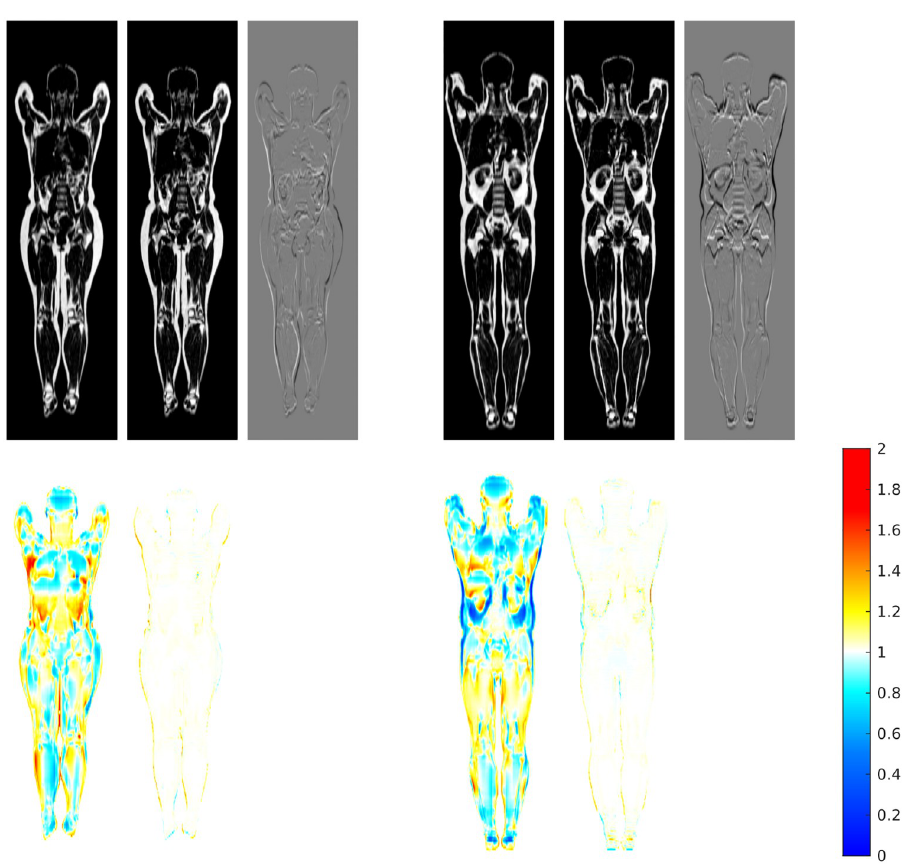
Fig 2. Generation of the synthetic reference for the registration of two different cohorts. Top row: slices of the initial and synthetic reference and difference images for the females (left) and males (right). Bottom row: Jacobian determinant for the initial and synthetic